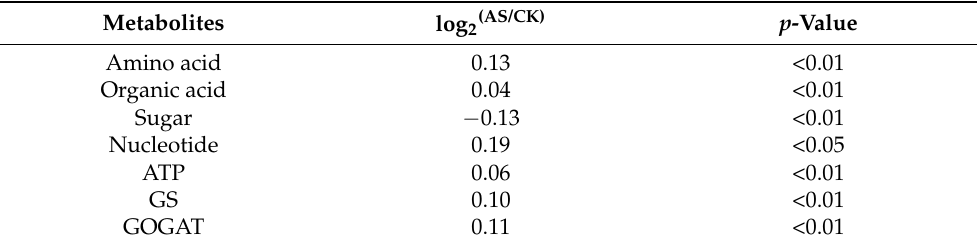
Table 5. The contents of metabolites, ATP, GS, and GOGAT of L. chinensis under normal and alkali conditions. The fold changes were calculated using the formula log 2(alkali/control) . Significant dif- ferences between control and alkali stress were defined with the t -test and labeled as p < 0.05 and p <